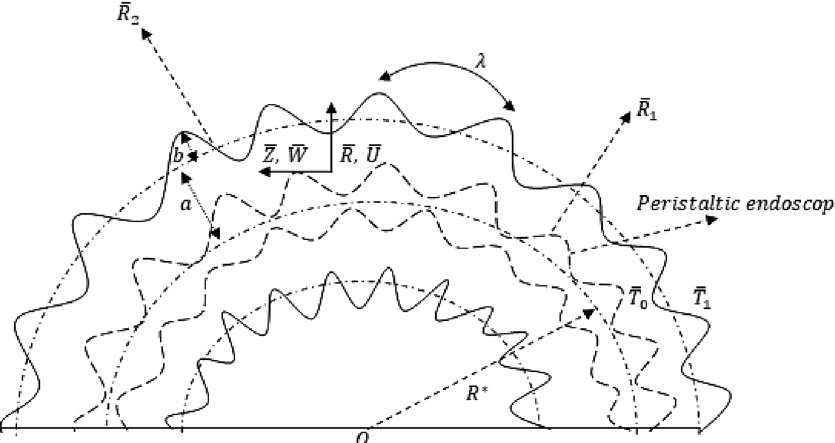
Figure 1. Geometrical model of the